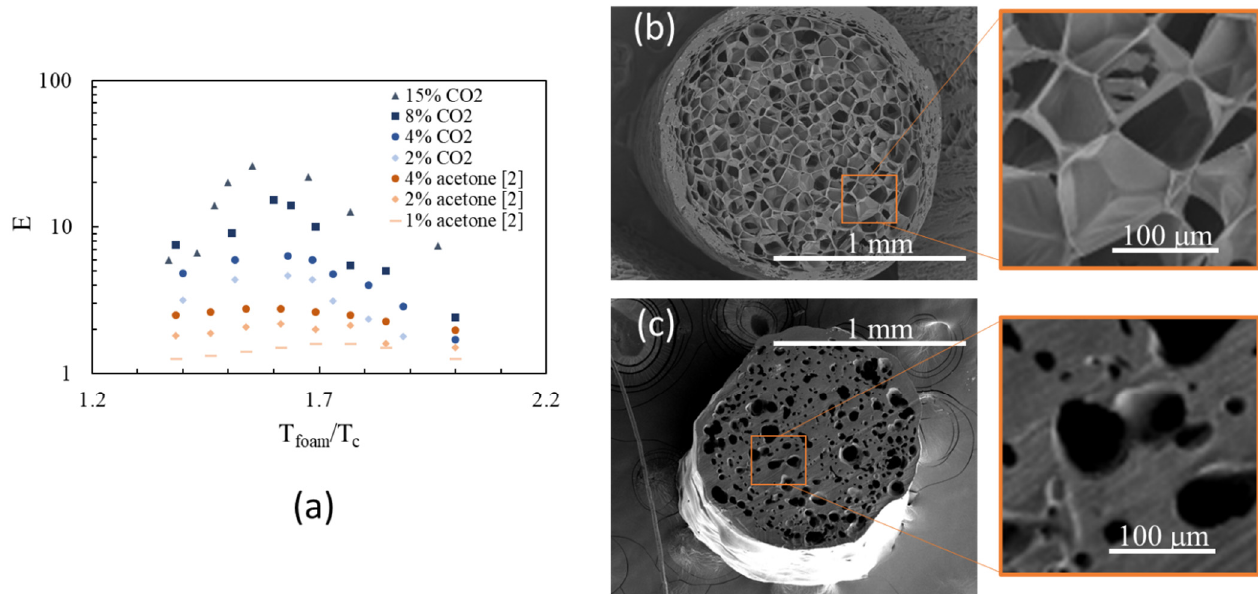
Figure 3. ( a ) Comparison between the expansion ratios achieved with CO 2 (this work) and acetone [2]. SEM images of the cross section of a strand foamed with CO 2 ( b ) and acetone ( c ).